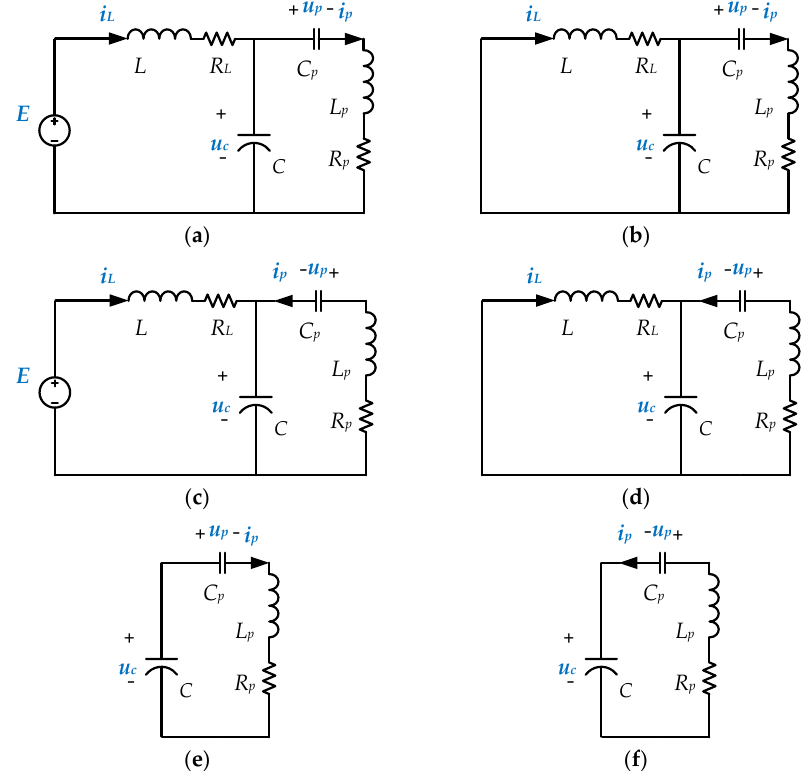
Figure 2. Equivalent circuits of the six working modes of the Buck-inverter system: ( a ) Mode 1; ( b ) Mode 2; ( c ) Mode 3; ( d ) Mode 4; ( e ) Mode 5; ( f ) Mode 6. Choose X = [ i L u c i p u p ] T and U = [ E ] as the state vector and the input vector of the